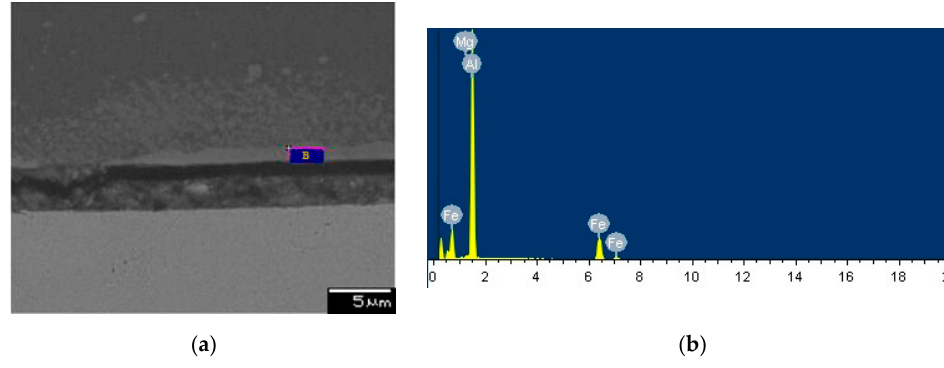
Figure 20. EDS analysis at point B. ( a ) SEM image; ( b ) Spectrum.